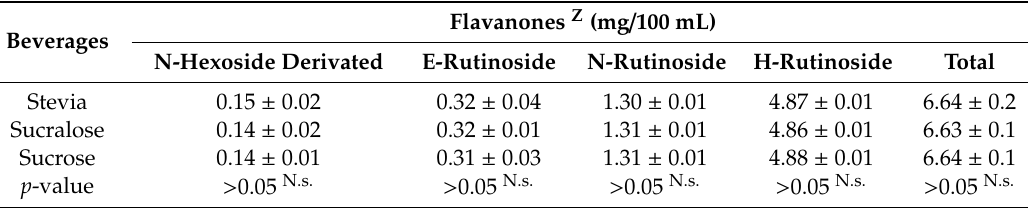
Table 1. Flavanones composition of the maqui-citrus juices developed using diverse